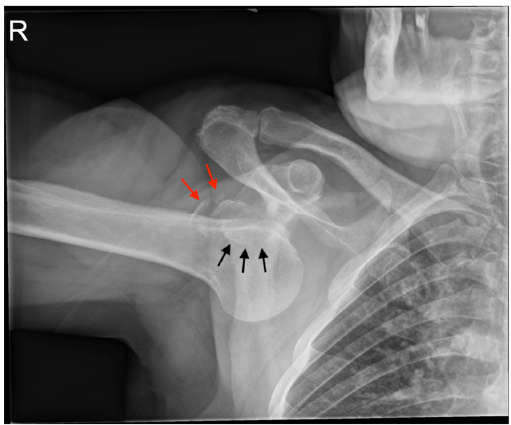
Figure 1. Plain radiography of the right shoulder with inferior dislocation: the arm is fixed in abduction under the inferior glenoid rim (black arrows), the greater tuberosity is fractured (red arrows). J. Clin. Med. 2022 , 11 , x FOR PEER REVIEW